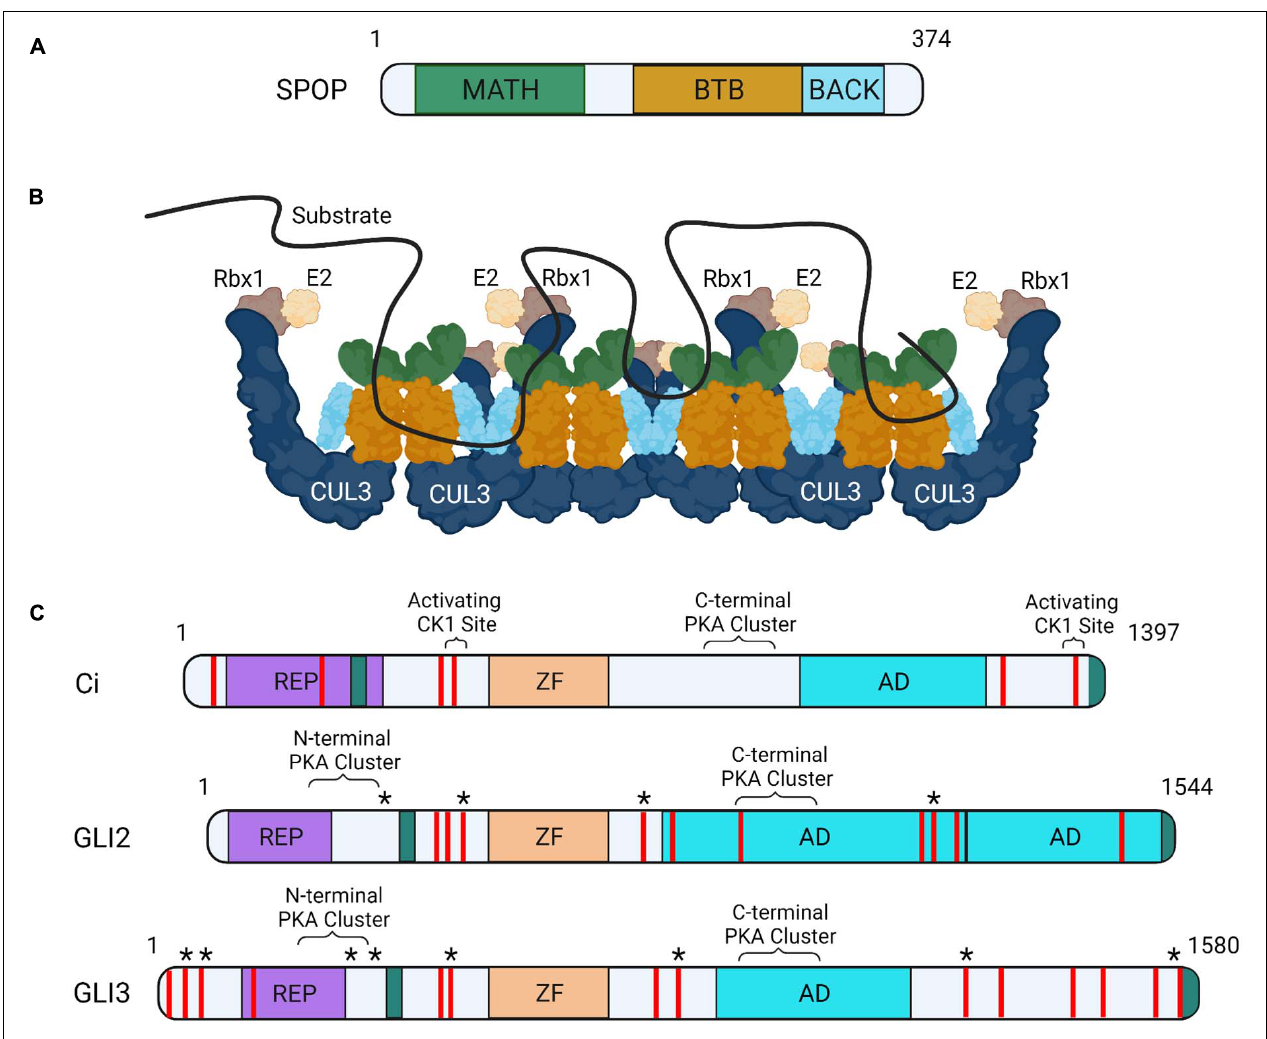
FIGURE 1 | Schematic of SPOP, CRL3-SPOP complex oligomer and substrates Ci and GLI. (A) MATH, BTB, and BACK functional domains are indicated on a schematic of mouse SPOP. (B) A schematic of CRL3-SPOP complex oligomer with substrate bound through multivalent interactions via multiple linear SBC motifs is shown. Each SPOP substrate adaptor protein (colors correspond to SPOP domains in A ) is drawn in association with a CUL3 scaffolding, corresponding Rbx1 (RING protein, tan) and E2 enzyme (cream). (C) Functional domains of Drosophila Ci, mouse GLI2 and human GLI3 proteins are shown. Regions of post-translational modifications influencing transcriptional activity are indicated (known PKA and CK1 sites in brackets, predicted “activating” CK1 sites are indicated with asterisks). SPOP recognition motifs are shown as red lines. SUFU interacting regions (teal), repressor domain (REP, purple), zinc finger domain (ZF, orange), and transcriptional activation domain (AD, blue) are also